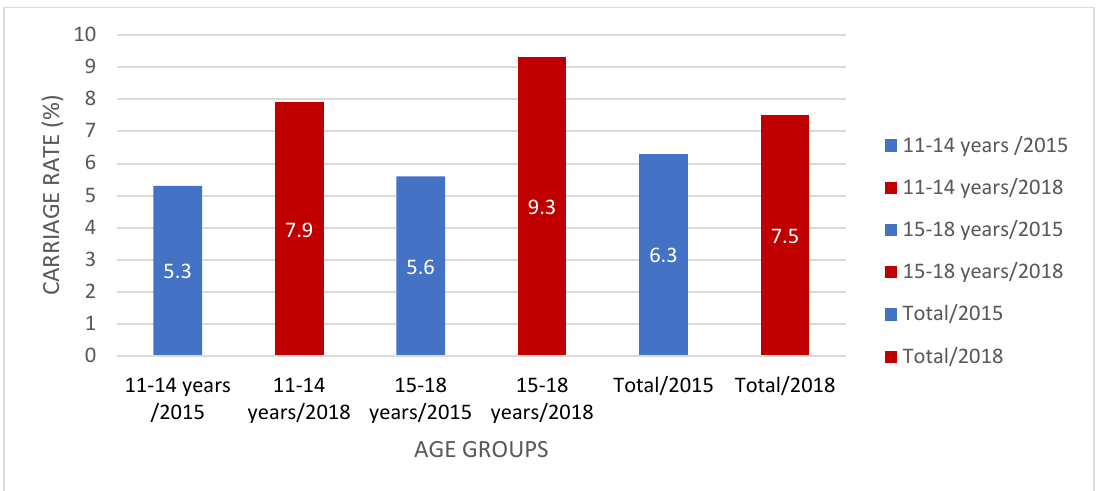
Figure 3. Meningococcal carriage rate (%) comparison in Turkey between 2015 and 2018.